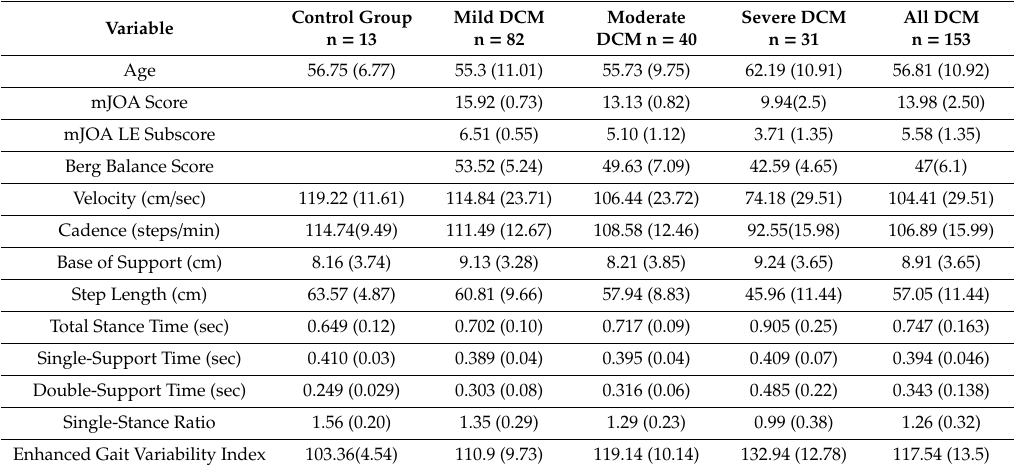
Table 3. Mean ( ± SD) of patient and gait specific parameters, stratified by the modified Japanese Orthopaedic Association (mJOA) scale. mJOA LE: mJOA lower extremity.